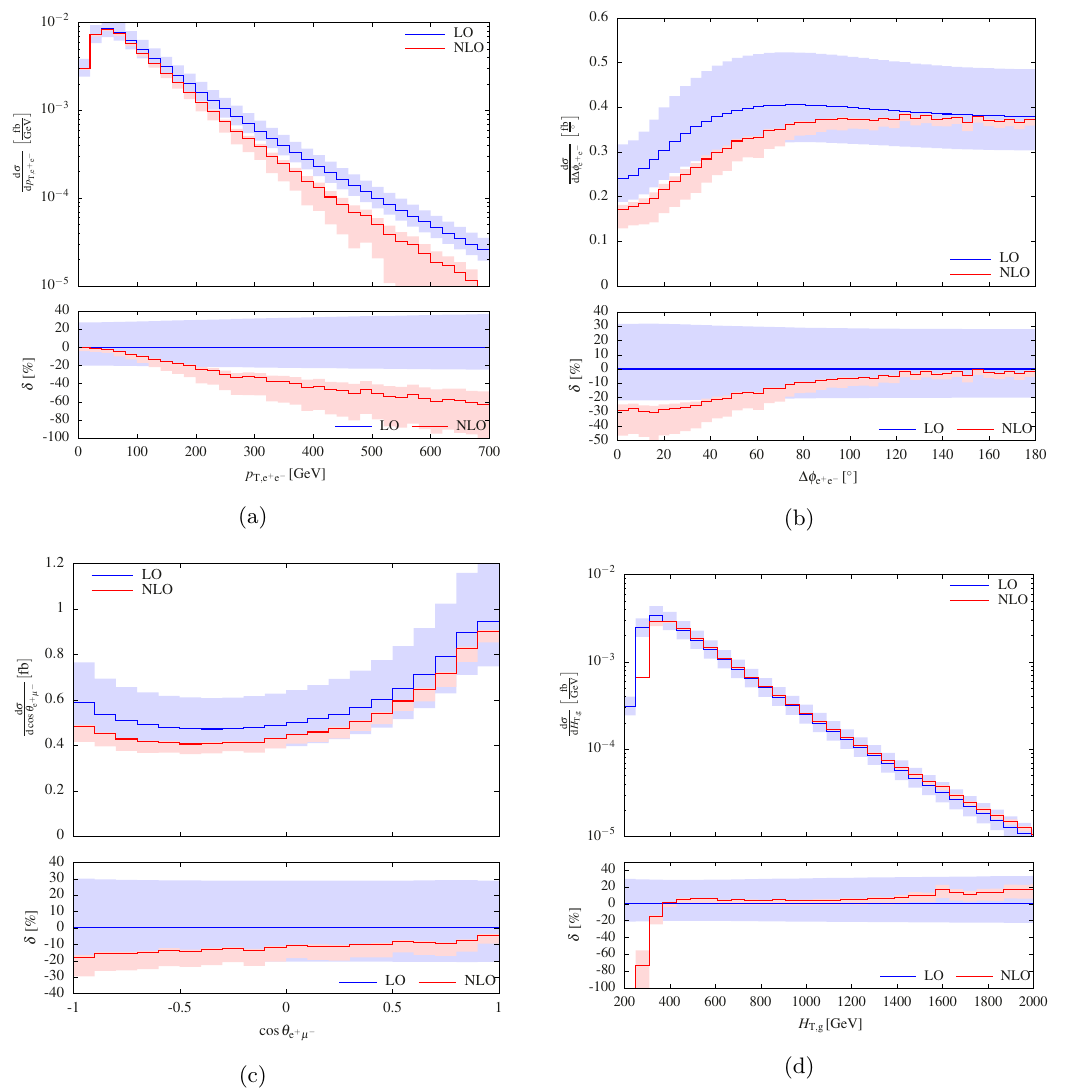
Figure 9 . Same as for figure 8 but for the observables: transverse momentum of the electron- positron system (top left), azimuthal angle between the positron and the muon (top right), cosine of the angle between the positron and the muon (bottom left), and total transverse energy H T (bottom